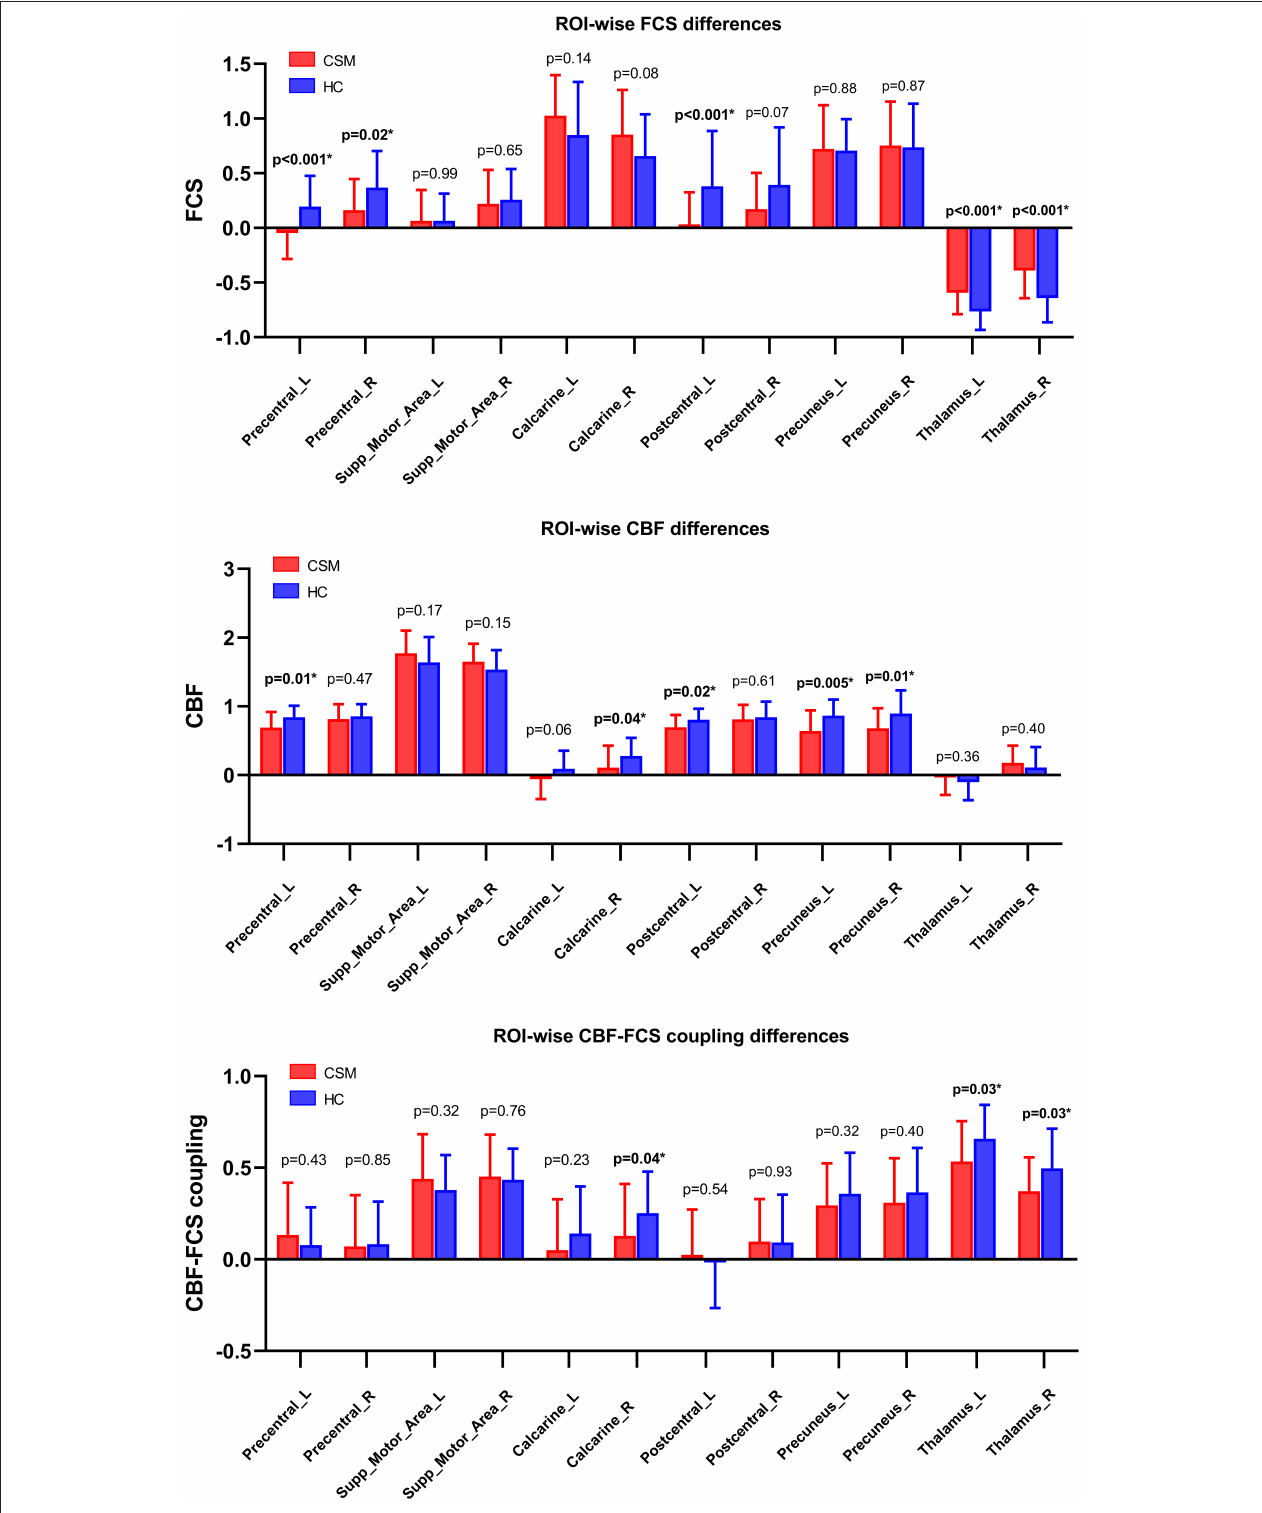
FIGURE 5 | CBF–FCS coupling changes in ROI in cervical spondylotic myelopathy (CSM) patients based on anatomical automatic labeling. We found significant difference in CBF–FCS coupling, as well as CBF rate and FCS. Error bars represent the SD. P -values (uncorrected) are shown above bars. CBF, cerebral blood